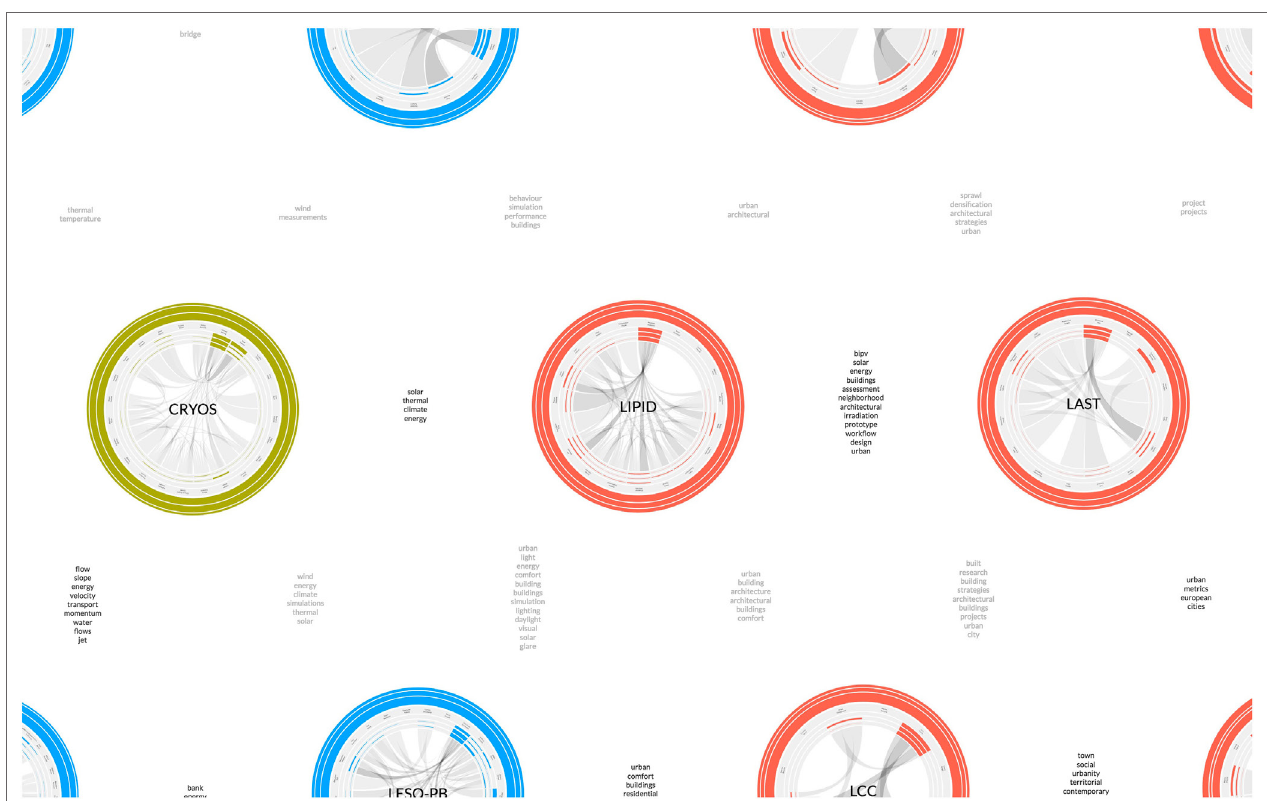
FigUre 3 | Keywords between laboratories indicate potential affinities. Zooming makes visible the keywords that correspond to laboratory common lexicon. Using the spatialization of the hexagonal grid, keywords adds a further information level that expresses the semantic of the